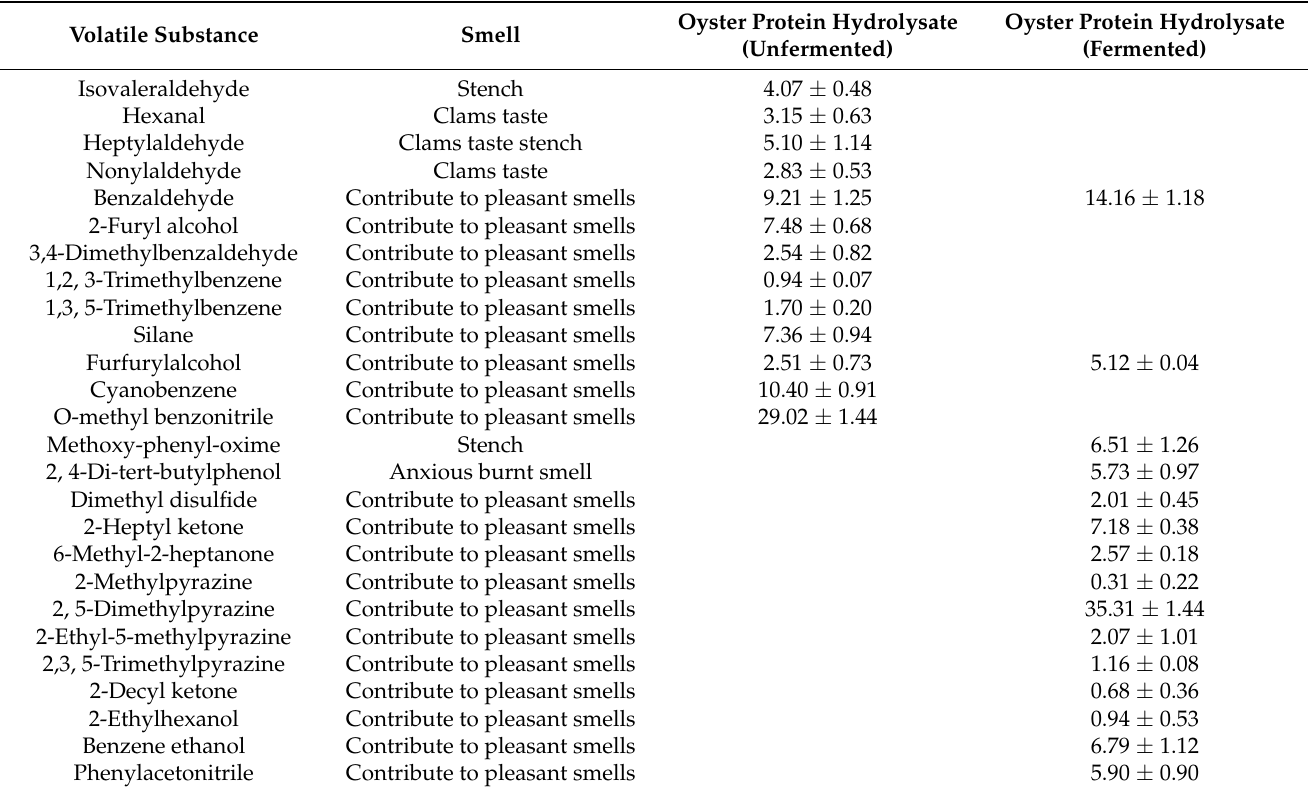
Table 3. Proportion of volatile flavor substances in fermented products